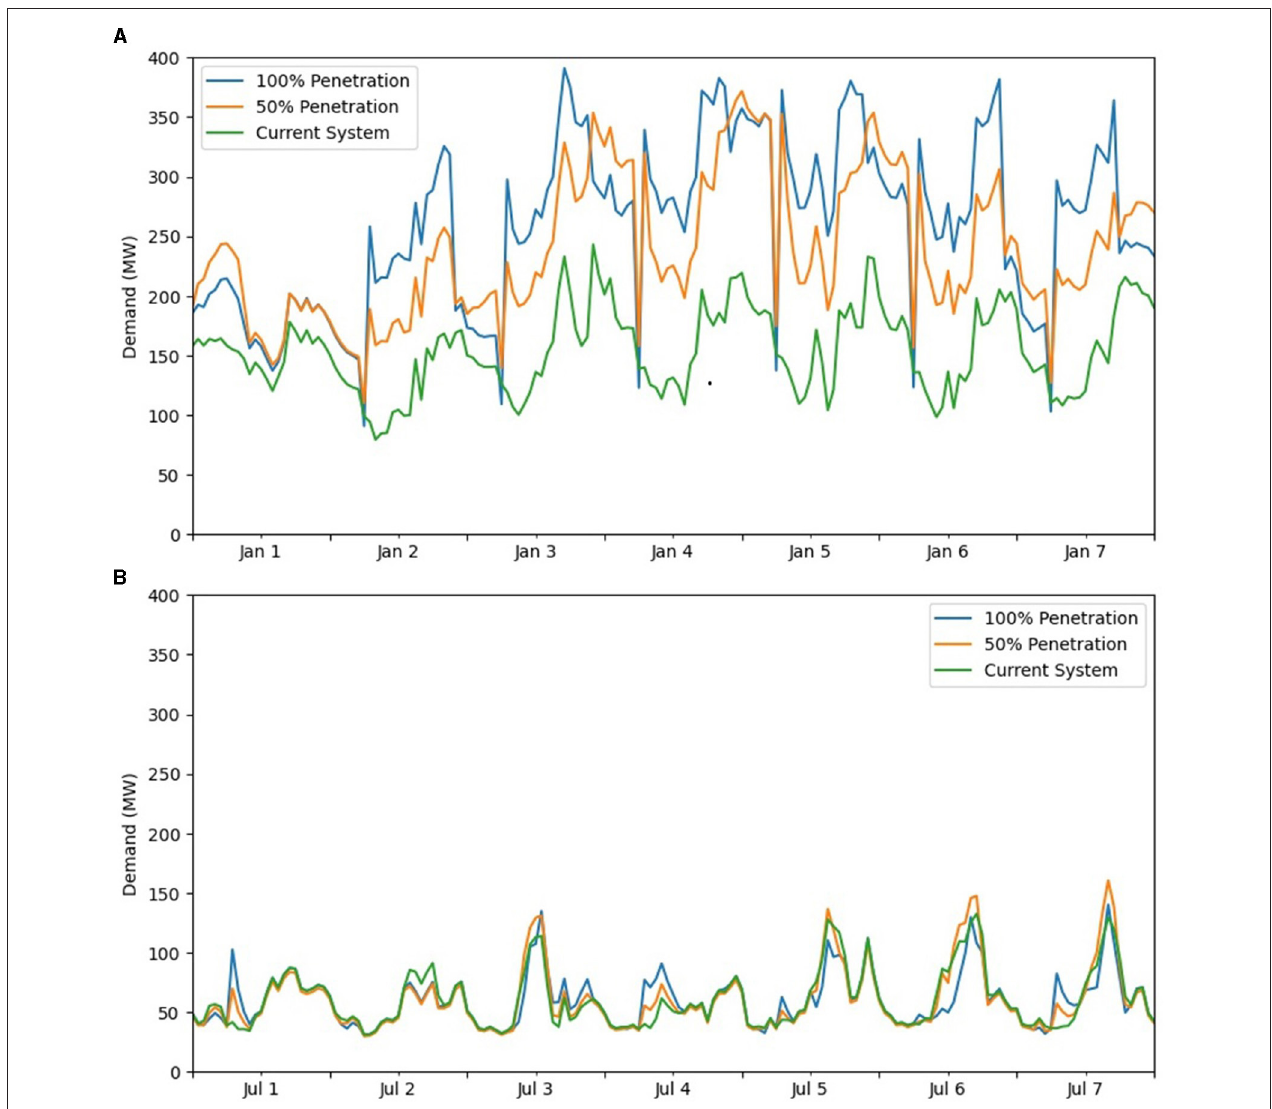
FIGURE 10 | Building demand load in 50% and 100% penetration scenarios in (A) winter (top) and (B) summer